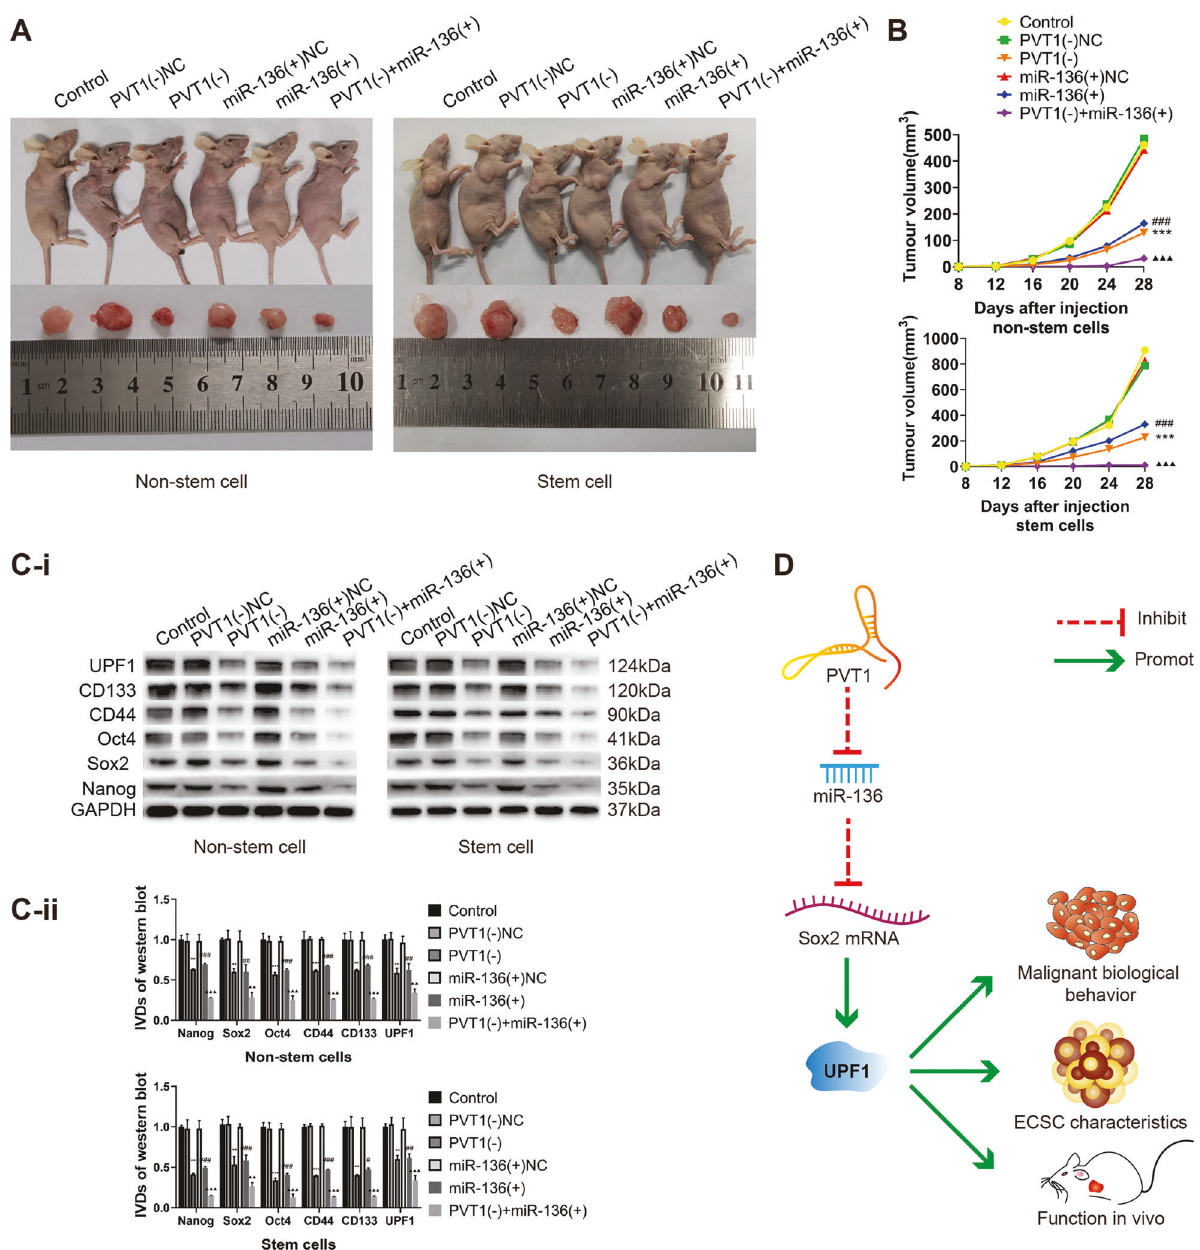
Fig. 7 Downregulation of PVT1 combined with upregulation of miR-136 can signi fi cantly inhibit the growth of xenograft tumors in nude mice. A Tumor-bearing nude mice and one tumor sample from each group are shown. B The volume of each group of tumors at different observation time. C Western blot was used to detect the expression of Sox2, UPF1, and stem cell markers in nude mouse tumors formed by endometrial cancer non-stem cells and stem cells. Data are presented as the means ± SD ( n = 3, each group), * P < 0.05, ** P < 0.01, *** P < 0.0001 vs. PVT1(-)NC group; # P < 0.05, ## P < 0.01 and ### P < 0.001 vs. miR-136(-)NC group; ▲ P < 0.05, ▲▲ P < 0.01, ▲▲▲ P < 0.0001 vs. miR-136(-) group. D Schematic diagram of the PVT1/miR-136/Sox2/UPF1 axis